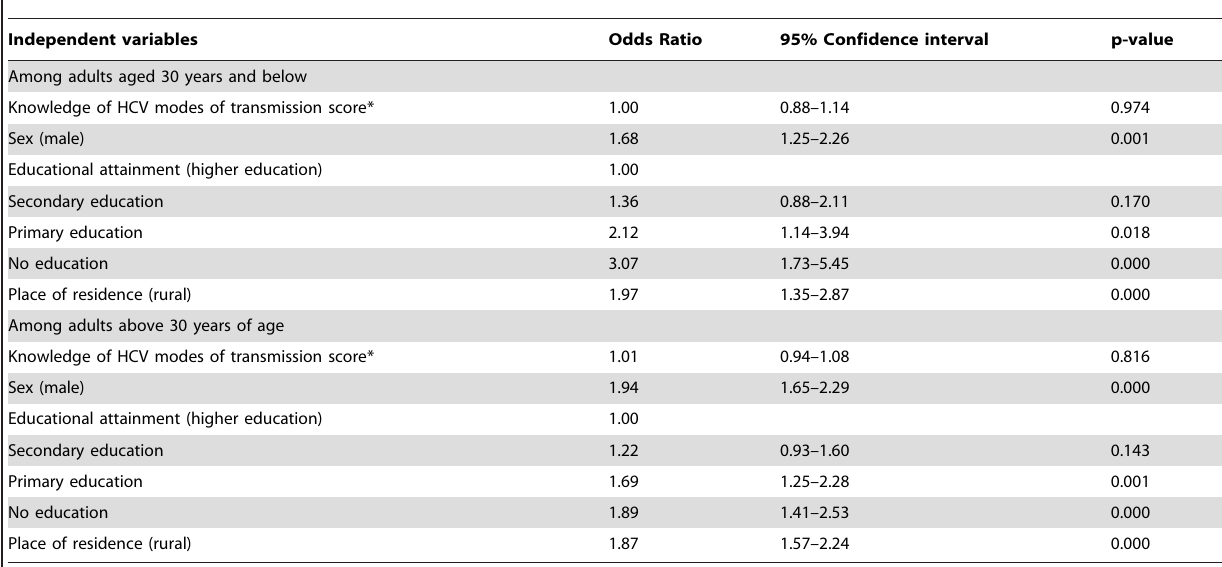
Table 4. Age-stratified multivariate logistic regression for the association between HCV antibody prevalence as dependent variable and knowledge of HCV modes of transmission score (with higher score indicating a higher knowledge level) controlling for sex, educational attainment and place of